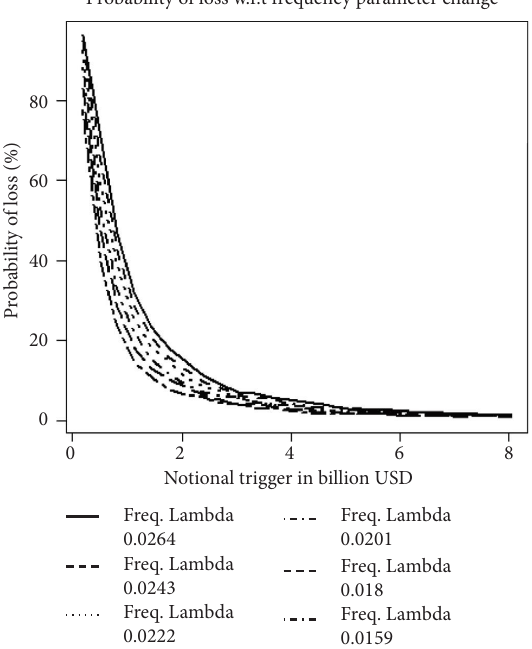
Figure 28: Cyber bond notional survival curve for 3years for λ in the interval λ ± λ · 25%.